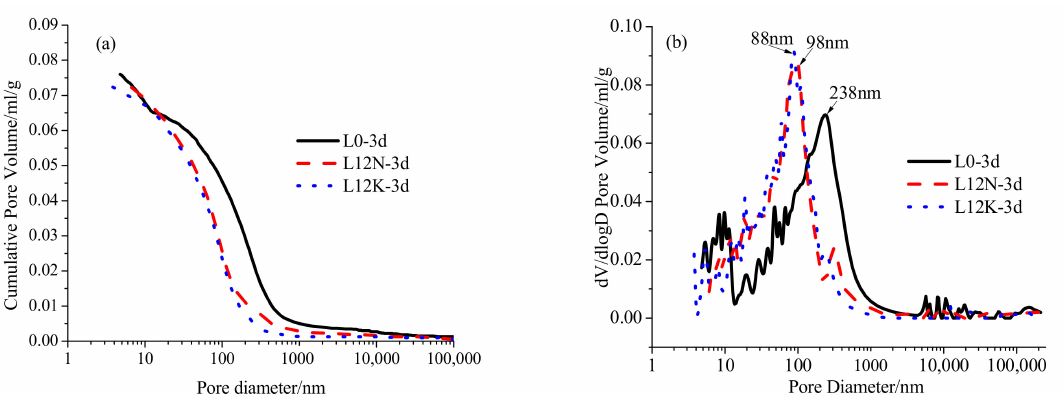
Figure 9. The curves of cumulative pore volume ( a ) and pore size distribution ( b ) of LHPC mortars with different alkali sulfates contents at 3 d.